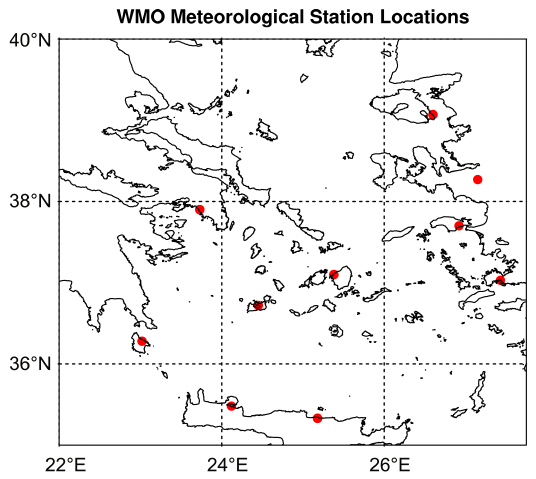
Fig. 8. Locations of the World Meteorological Organization (WMO) stations used in the statistical